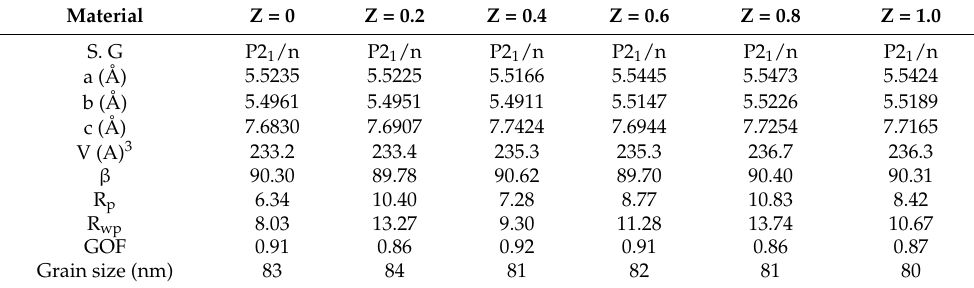
Table 1. Refined lattice parameters of La 2 Co 1 − z Fe z MnO 6 (z = 0, 0.2–1.0). Material Z = 0 Z = 0.2 Z = 0.4 Z = 0.6